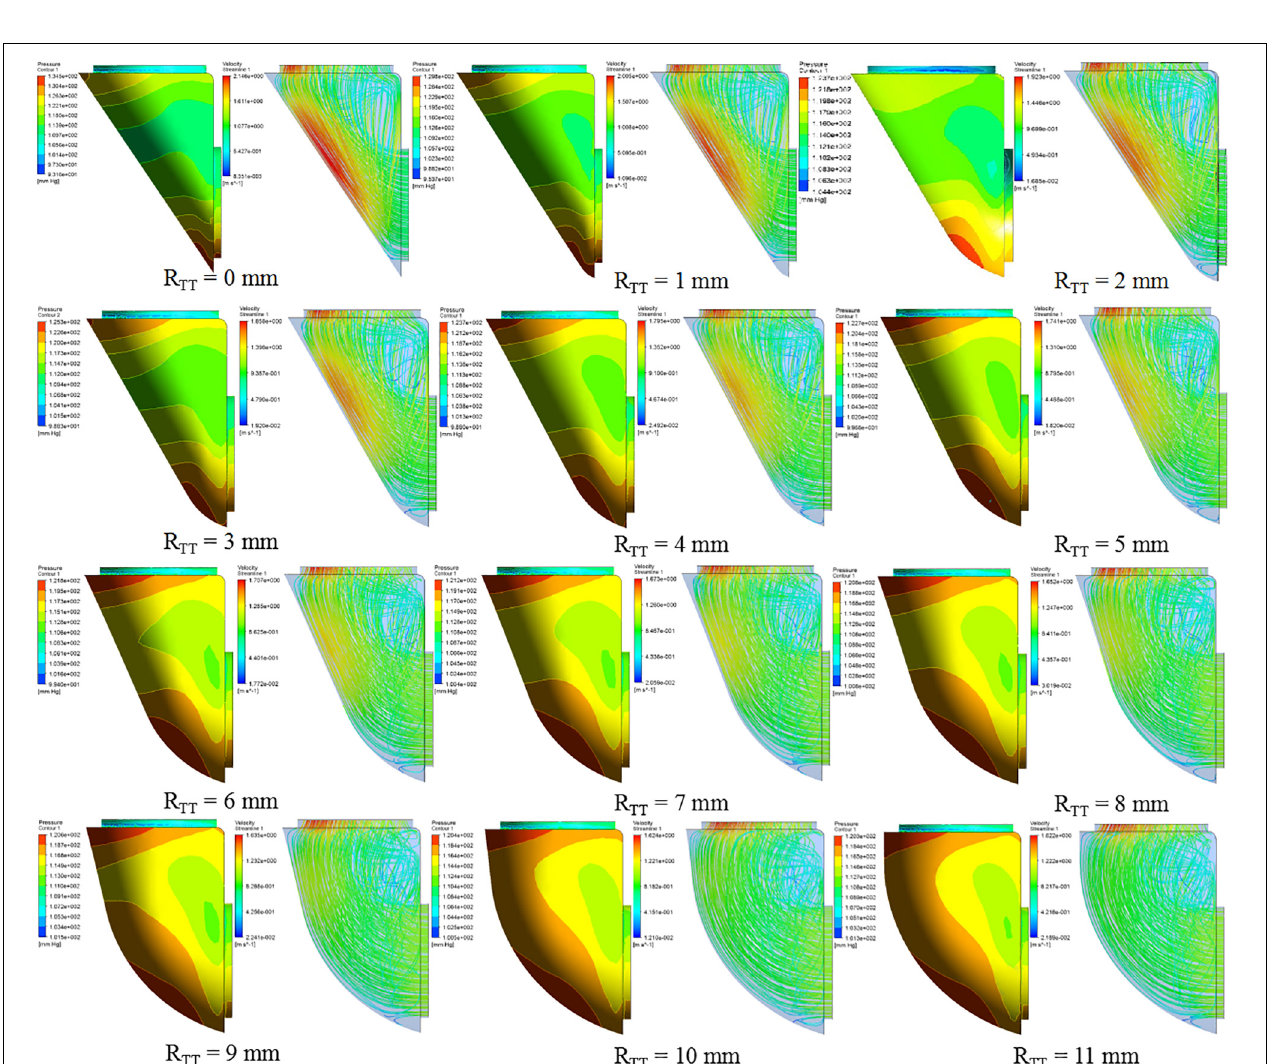
FIGURE 3 | The distribution of pressure and streamline of 12 groups of different R TT models.